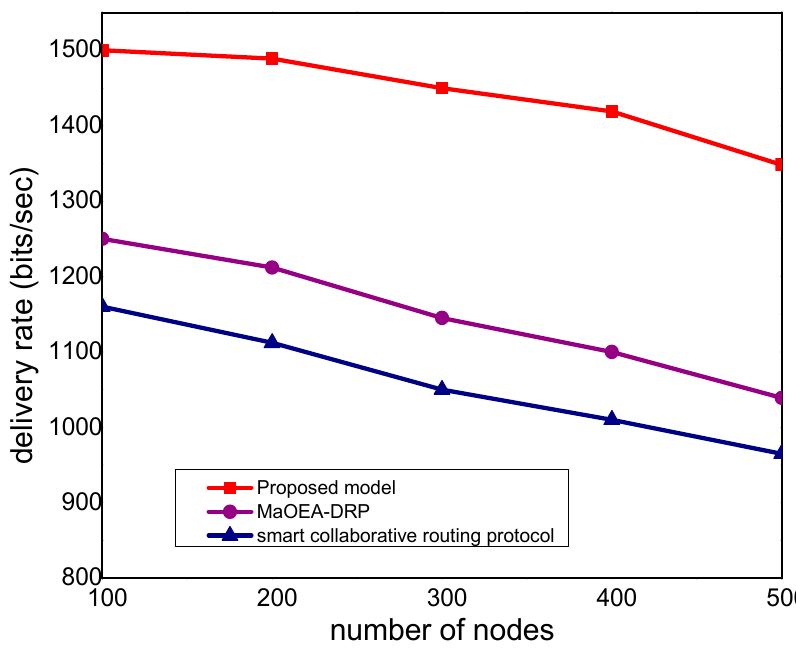
Figure 3. Delivery rate with the number of nodes.